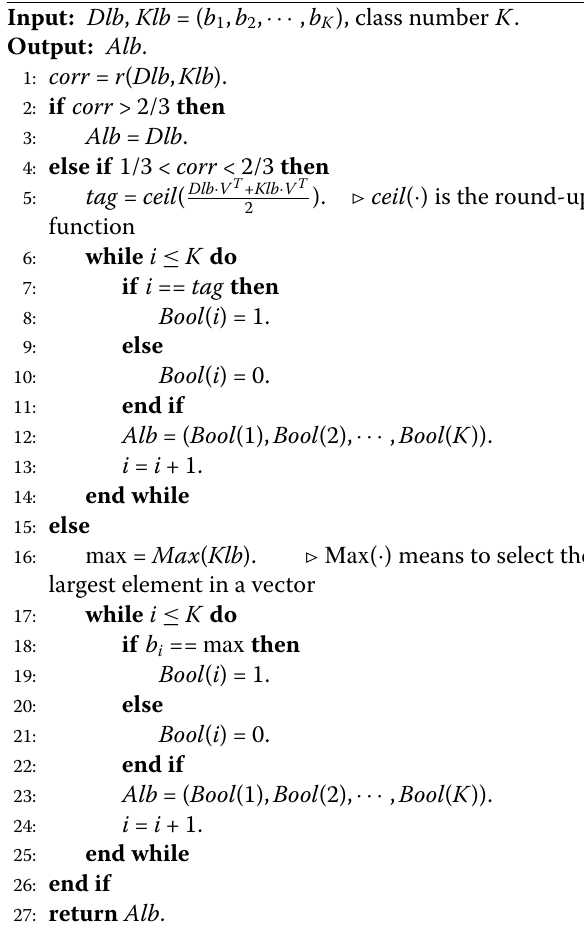
Algorithm 1 Label Update